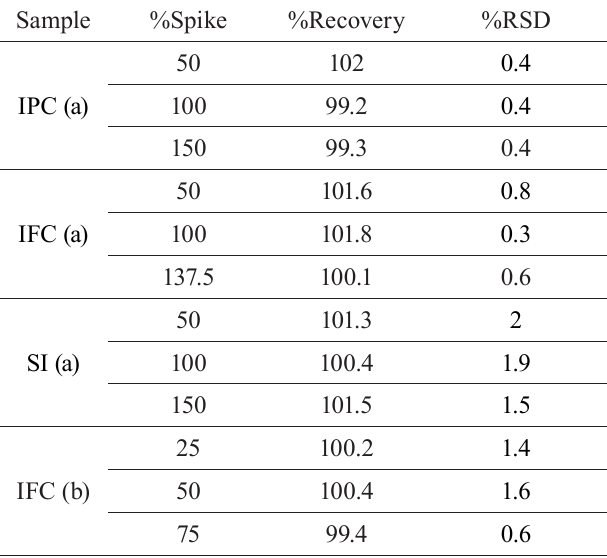
TABLE VII - The %Recovery of microwave digested dietary supplements for different spike percentages. (a) Iron, (b) Zinc Sample